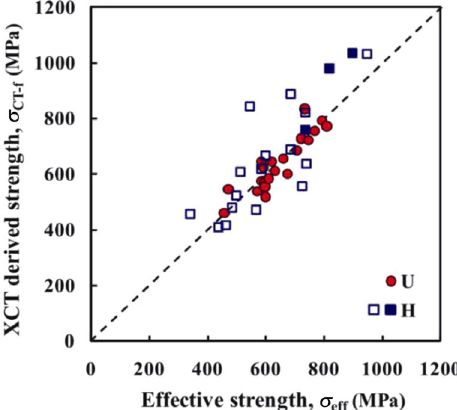
Fig. 40 Correlation between the effective and the XCT derived strengths. Open symbols correspond to surface defects and solid ones to volume defects (i.e., agglomerates for U samples and pores for H samples). Reproduced with permission from Ref. [105], © Elsevier Ltd. 2019.